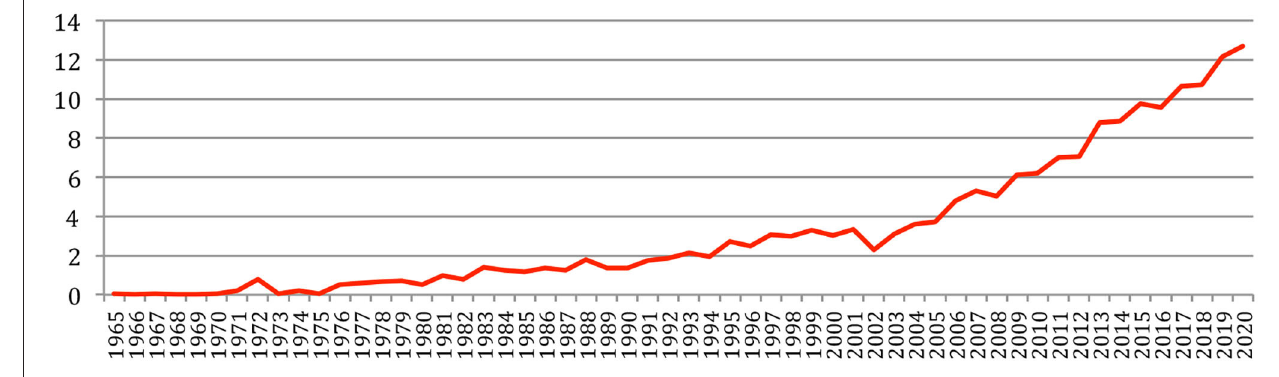
FIGURE 15 | The average number of references per paper over the years.